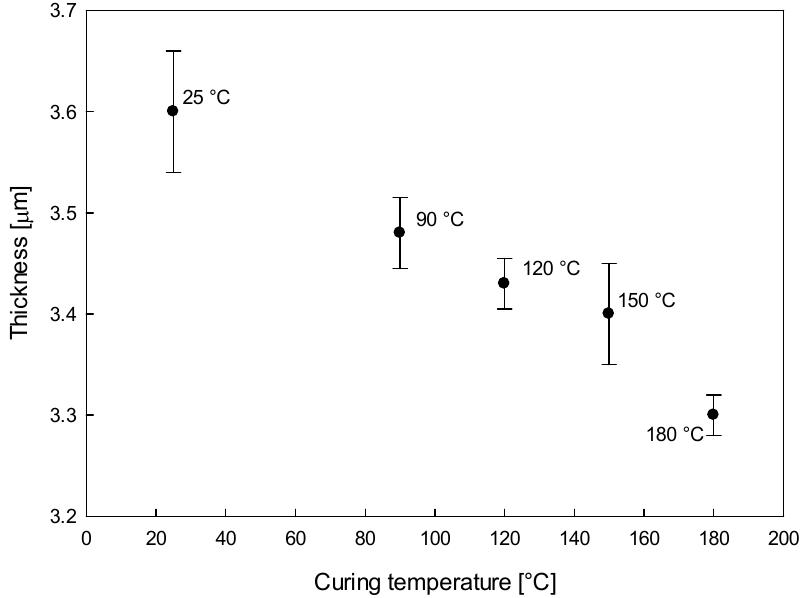
Figure 3. PBMA-siloxane coating thickness with error bars deposited on structural steel vs. curing temperature. The withdrawal rate was 2.3 mm/s.